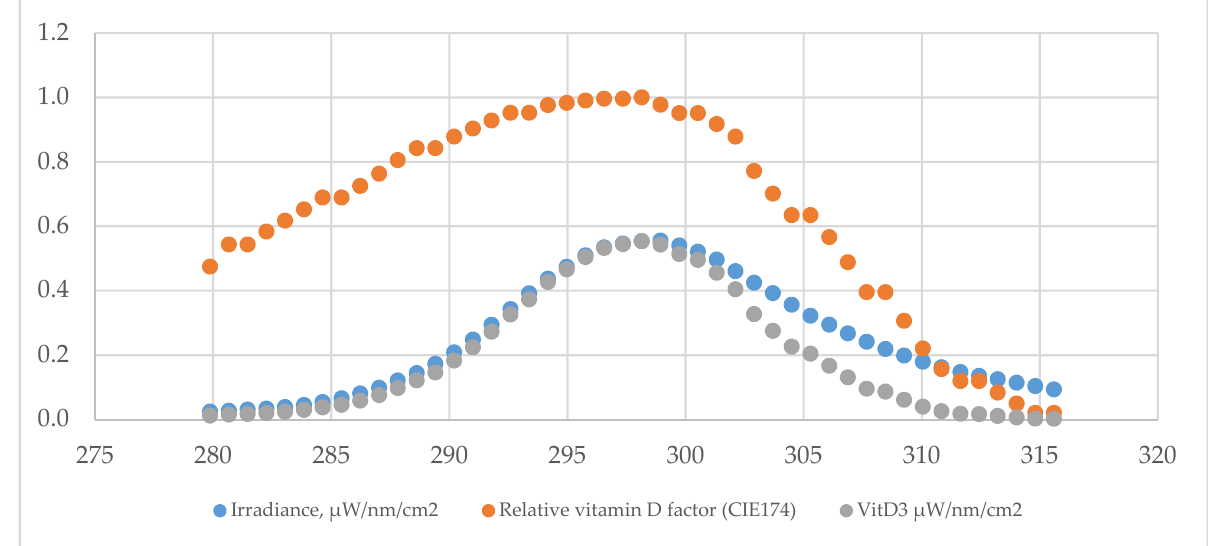
Figure A3. Illustration of the total irradiance, the vitamin D producing irradiance, and the relative factor for the conversion of 7-dehydrocholesterol to vitamin D 3 at each